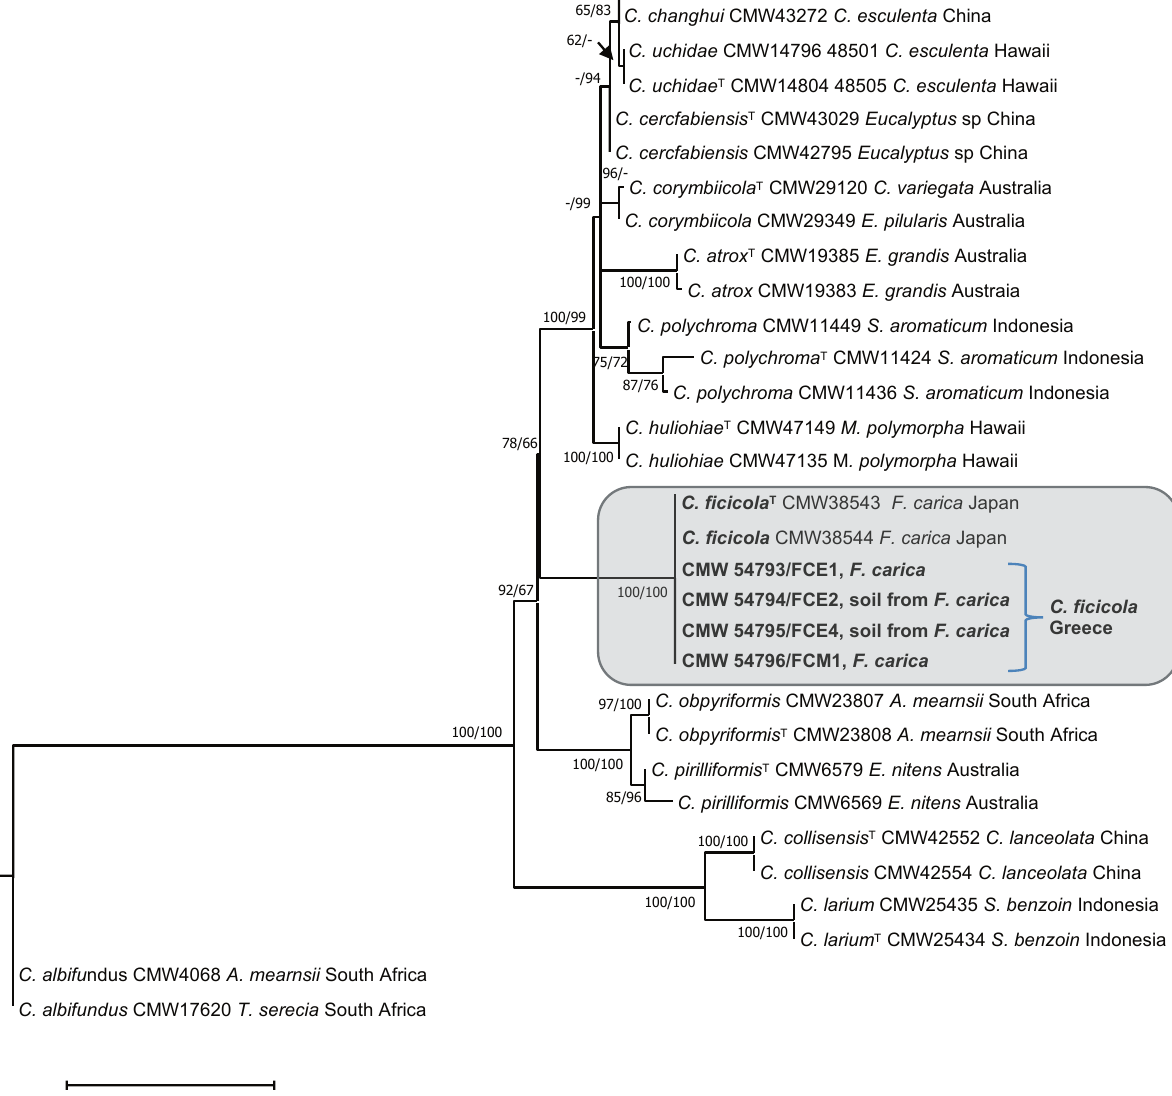
Figure 3. Phylogenetic placement of the isolates from Greece with Ceratocystis ficicola from Japan in the Asian-Australian Ceratocystis Clade. The ML phylogeny, constructed from the combined regions of the rpb2 , bt1 and tef1 gene sequences, is presented with MP and ML bootstrap values >60 % indicated on the branch nodes. T indicates ex-type representatives of each species. Ceratocystis albifundus was used as the